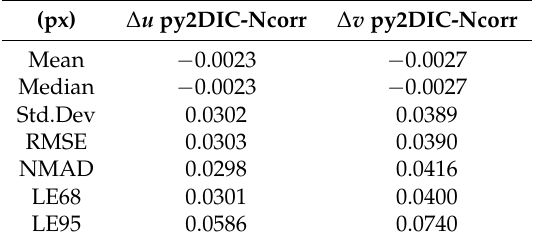
Figure 6. v displacements (px) for the “plate hole” sample from SEM DIC challenge obtained from DIC technique. ( a ) py2DIC raw results ( b ) py2DIC smoothed results using Gaussian filter ( c ) Ncorr results ( d ) Vic-2D results ( e ) DICe results. Table 3. Comparison with Ncorr : statistical parameters of displacement differences.